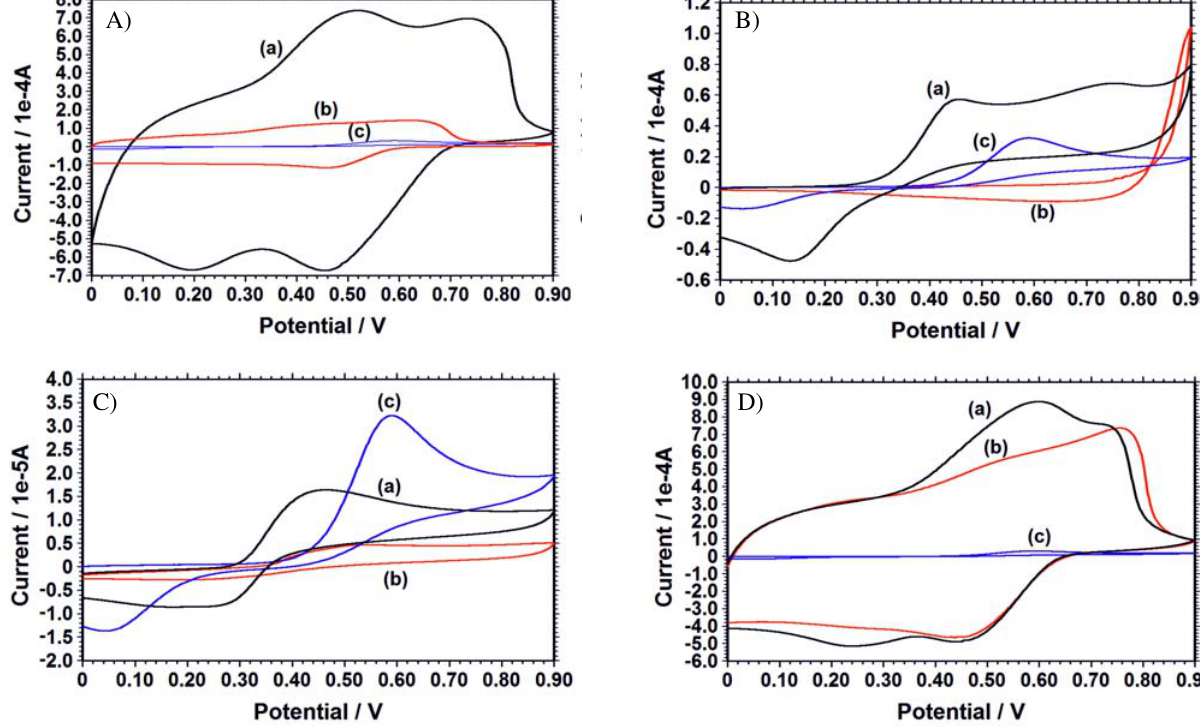
Figure 3. Cyclic voltammograms of (A) PANI, (B) P3MT, (C) PDAB, and (D) PANI-P3MT PDAB coated electrodes of (a) sulfate buffer contai- ning 5.0 mM HQ of the films, (b) sulfate buffer of the films, and (c) 5.00 mM HQ over uncoated Pt electrode (v = 100 mV s –1 , vs. SCE)